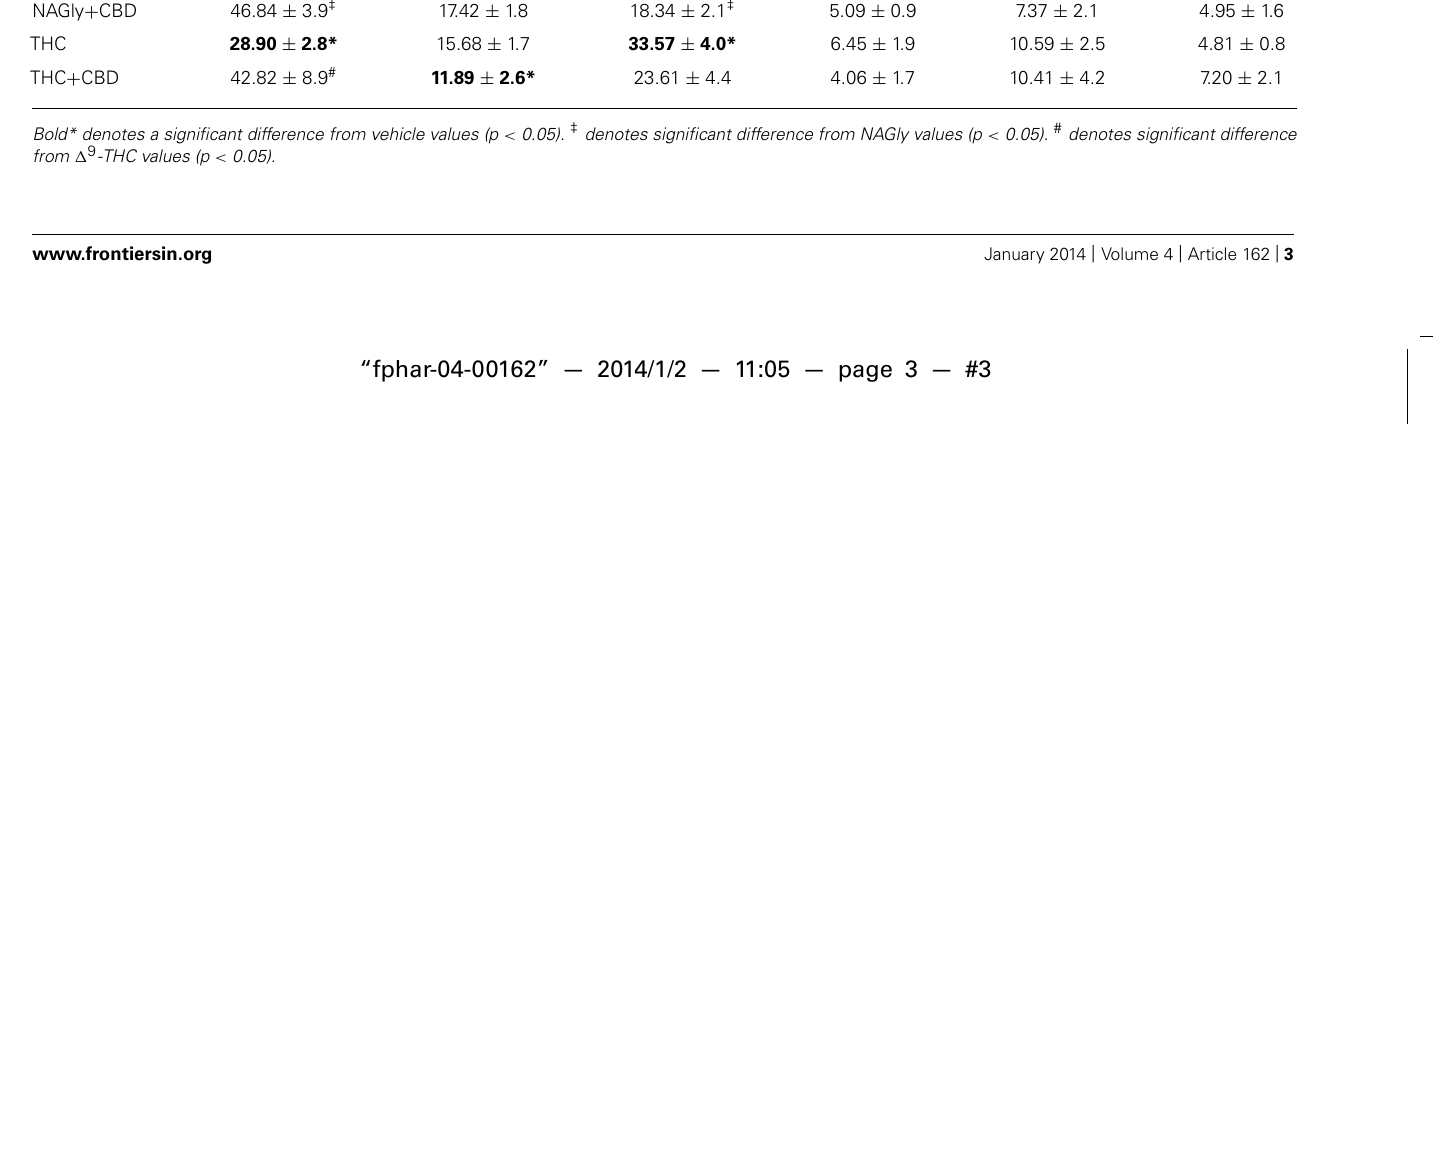
OPN,OPG,Prolactin,Pro-matrixmetallopeptidase-9(Pro-MMP- 9), P-selectin, Resistin, SCF, SDF-1 α , TPO, VCAM-1, VEGF, and VEGF-D.